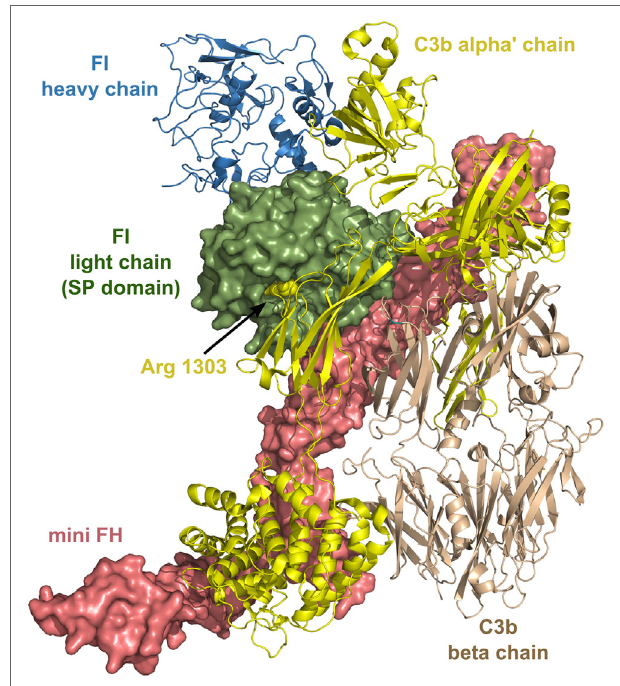
FiGURe 7 | Structure of the complex of C3b, mini factor H (FH), and factor I (FI). Mini FH is a potential drug candidate. In vitro , it is more effective than full-length FH in accelerating the decay of C3b by FI. The structure shows extensive contacts between the three proteins. The figure was made based on the structure of ternary complex of C3b-mini FH-FI (S525A) (184) (PDB entry 5O32). The colors of the legends match the depicted protein chains. The P1 residue (Arg 1303 ) of the primary cleavage site in C3b by FI is indicated by sphere representation. Mini FH and the light chain of FI are shown by surface representation, whereas C3b and the heavy chain of FI are shown by ribbon